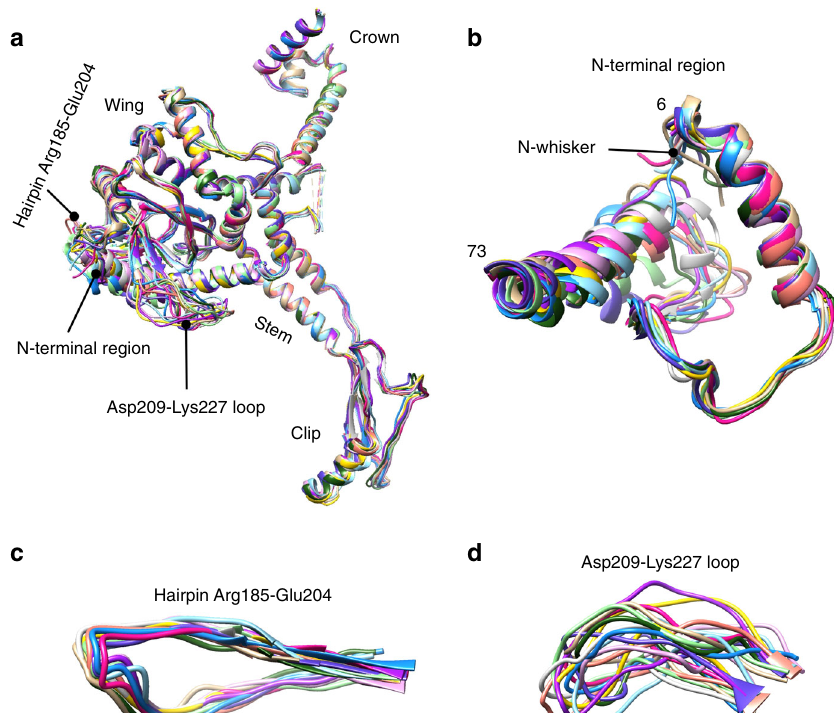
Fig. 3 Superimposition of all the twelve gp20 subunits within the portal assembly. a The gp20 subunits. b N-terminal region of gp20 subunits. c Hairpin Arg185-Glu204 of gp20 subunits. d Asp209-Lys227 loop of gp20 (Fig. 1f), which is disordered in the recombinant portal structure